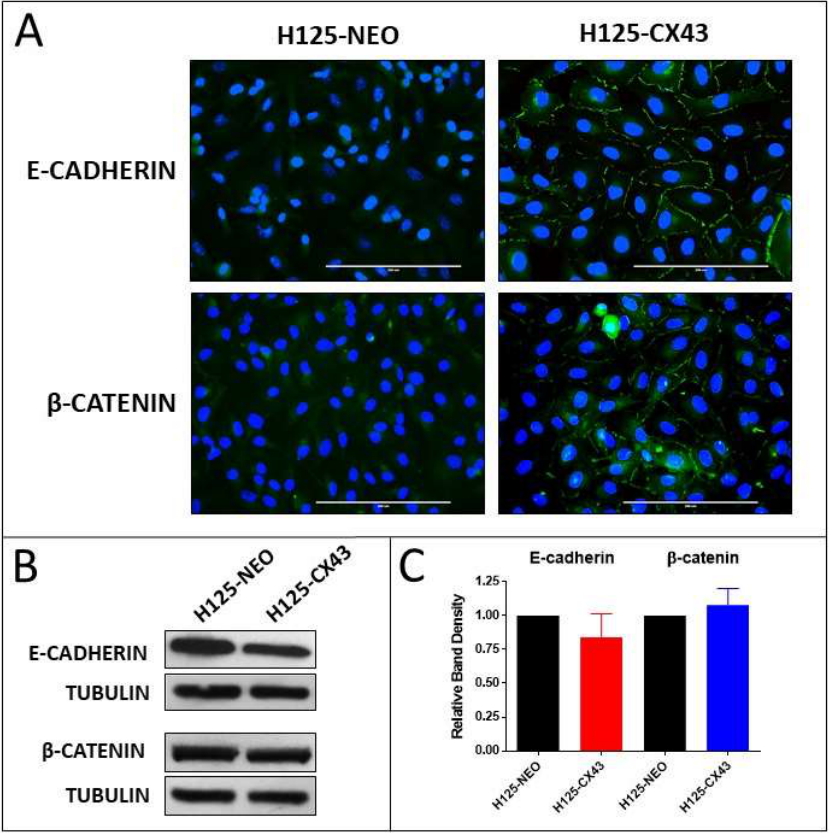
Figure 2. Localization and expression of E-cadherin and β -catenin in H125 cells. ( A ) Fluorescent FITC immunostaining of E-cadherin and β -catenin with DAPI staining of nuclei, scale bars: 200 µ m; ( B ) Western blots of E-cadherin and β -catenin and ( C ) densitometric analysis of band densities normalized to tubulin loading control and to H125-NEO cells (no statistically significant differences; one-sample t-test, mean ± S.D., n = 3 replicate experiments).